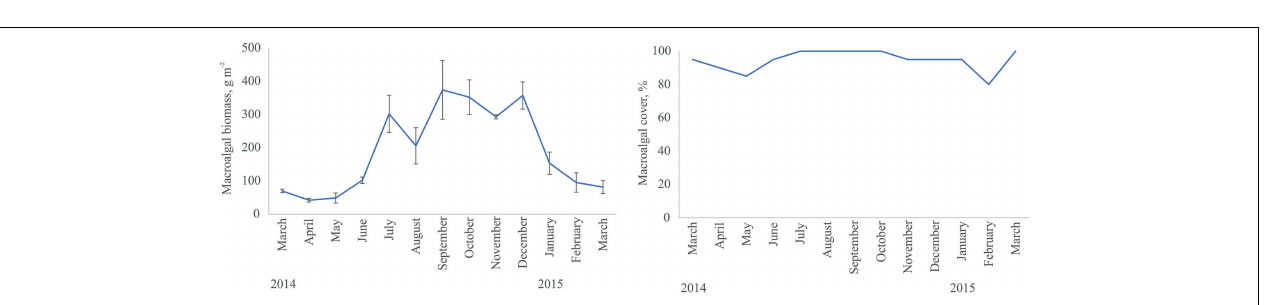
and December. August stood out among other